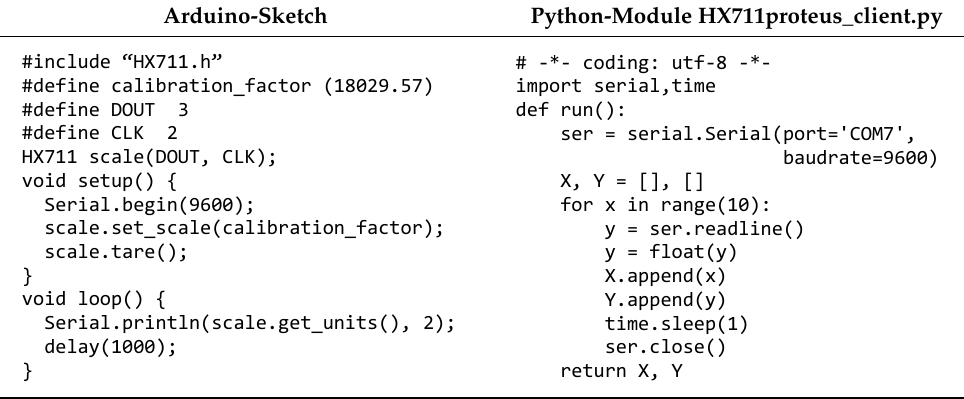
Table 2. Programs for data transfer via serial port.